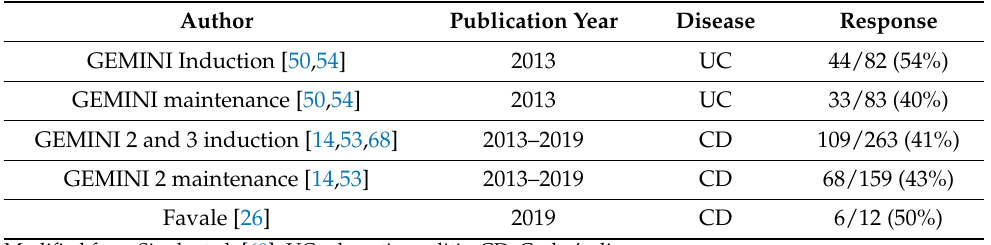
Table 2. Efficacy of vedolizumab in primary failures to anti-TNF